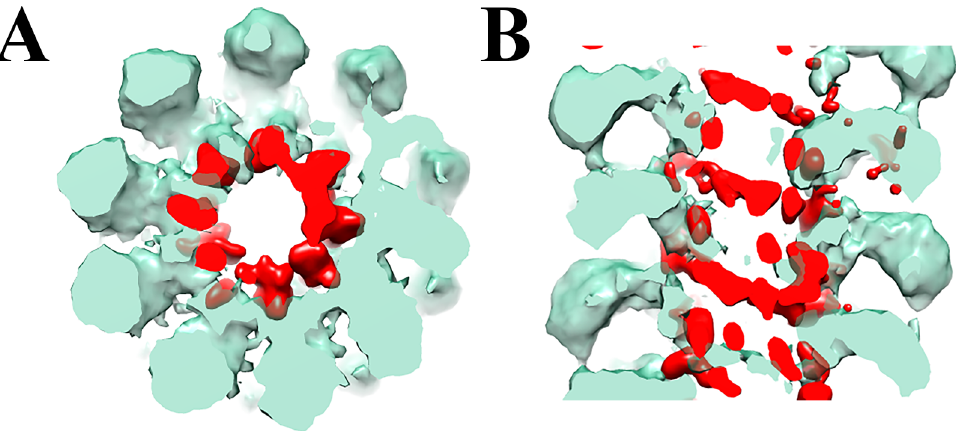
Fig 3. Difference map (red) between aligned to each other AltMV VLP and virion, superimposed onto a 3D structure of a VLP (transparent green). A. Sagittal section. B. Cross